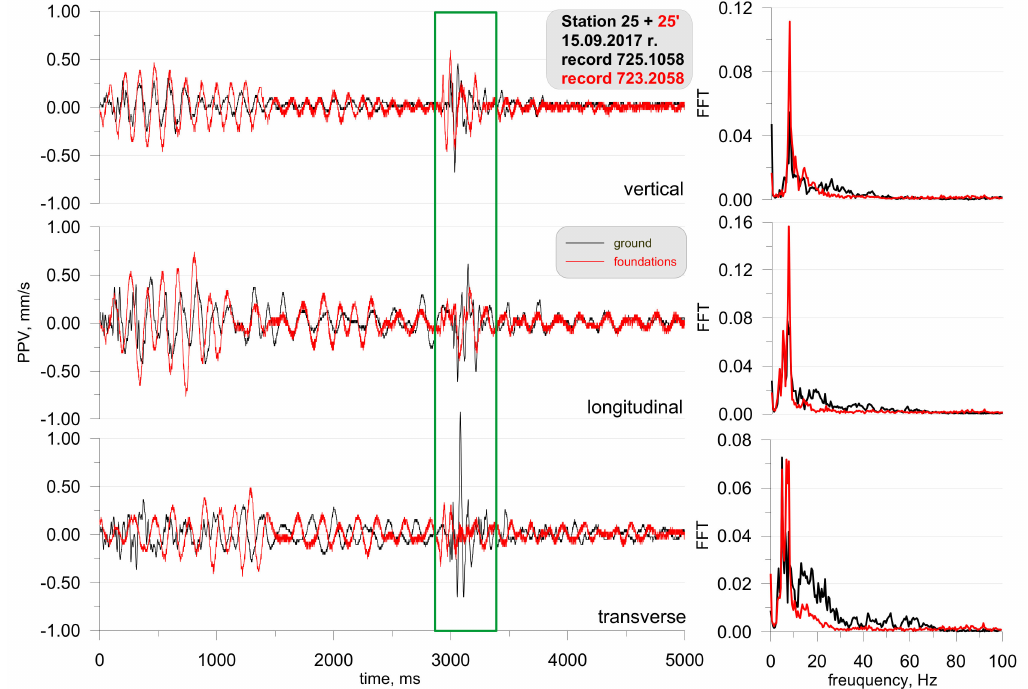
Figure 7. Seismogram of the vibration of the ground and building foundation (three directional components) combined with the analysis of the FFT-Station